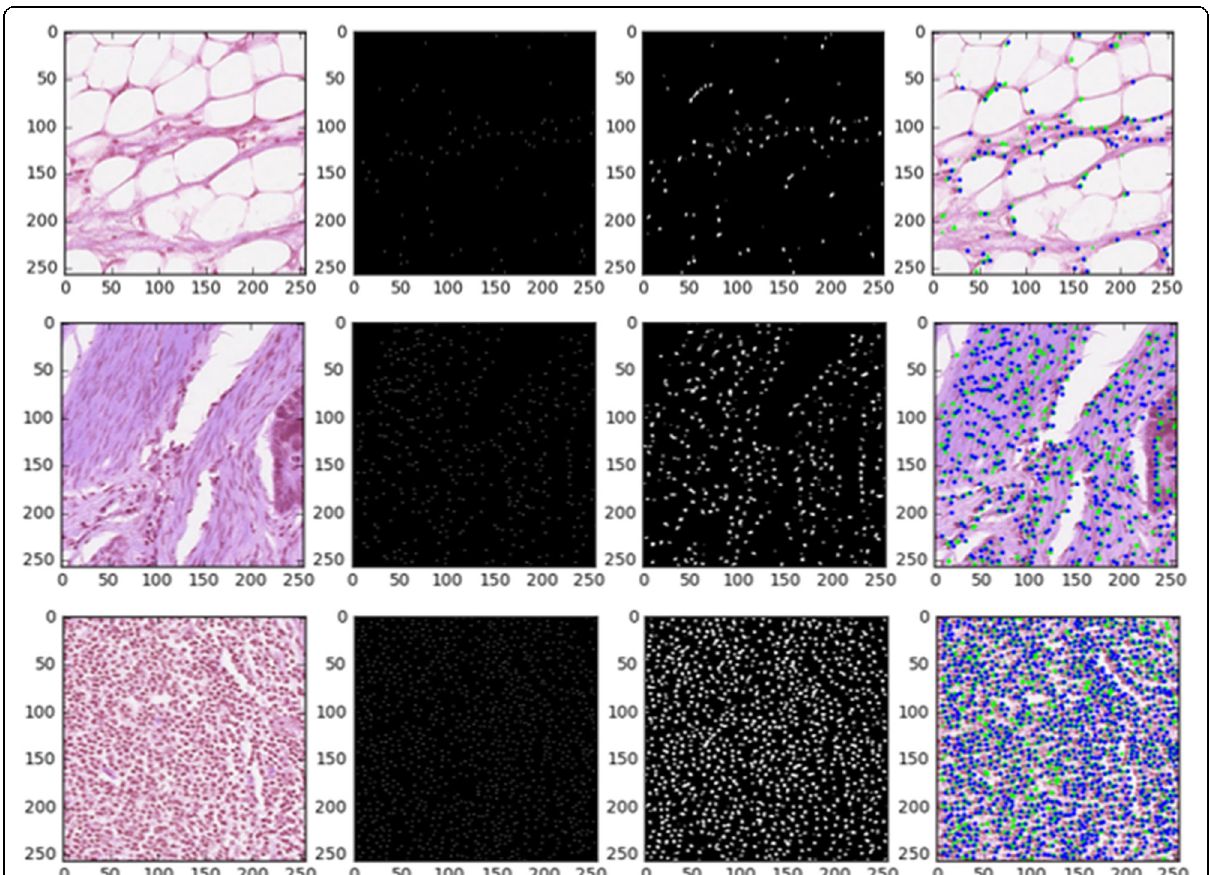
Fig. 16 Nuclei detection outputs with large images: the first column shows the input images, the second column shows the ground truth mask, the third column represents the predicted mask by the model, and the fourth column shows the final results where green and blue dots represent the ground truth and detection